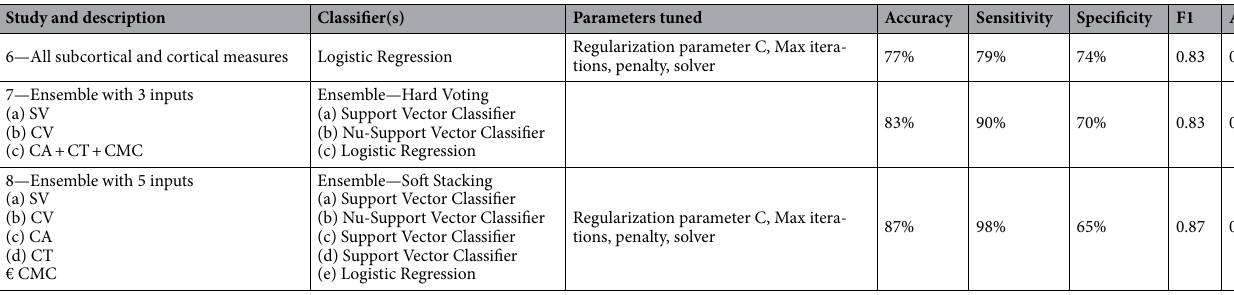
Table 3. Classification performance using all measures.